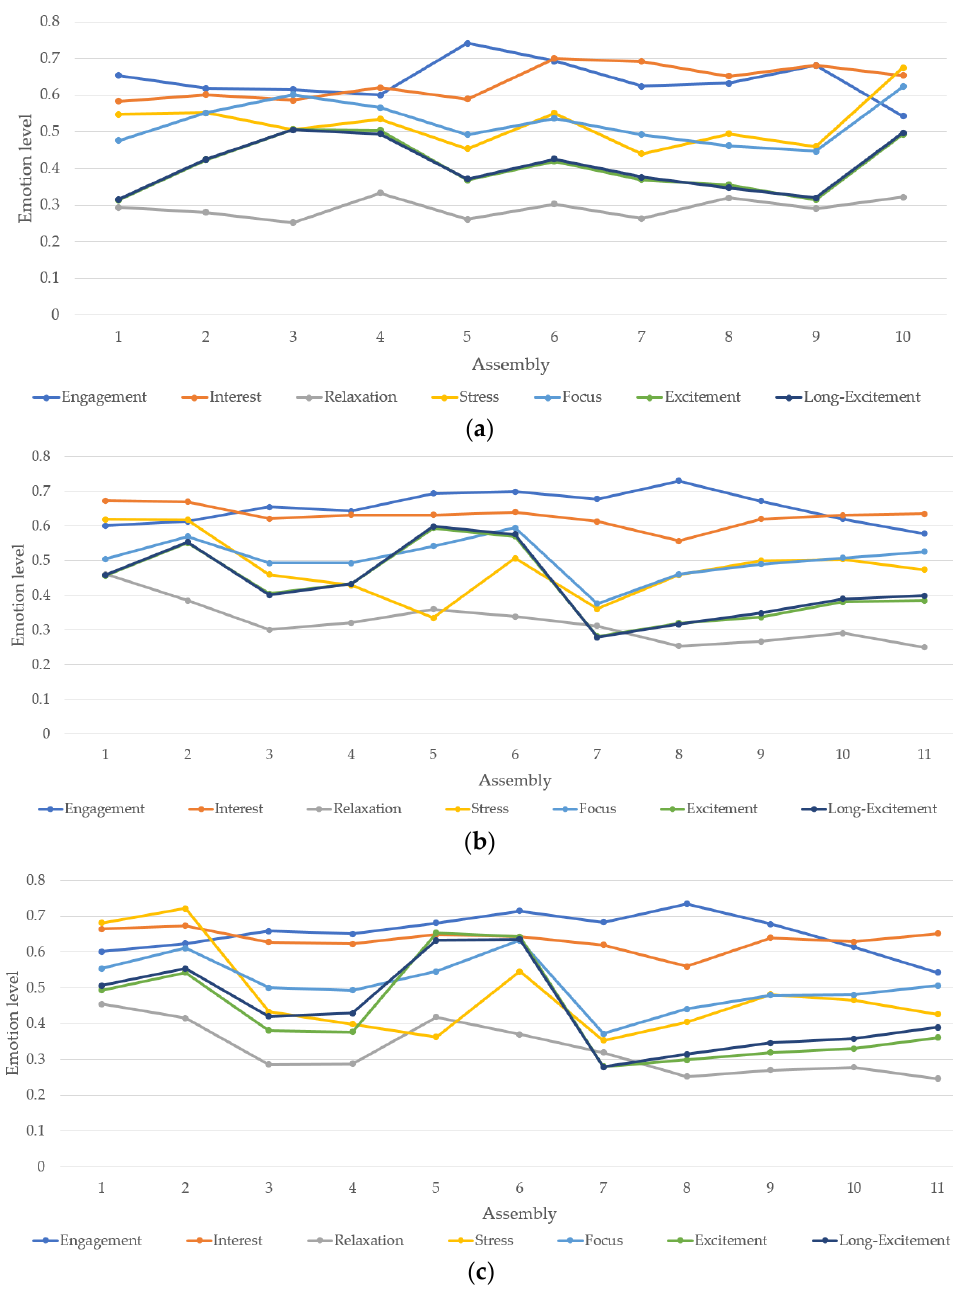
Figure 9. Average values of human profiling process: ( a ) box assembly alone, ( b ) box assembly with the cobot including the waiting time for the cobot, ( c ) box assembly with the cobot excluding the waiting time for the cobot.